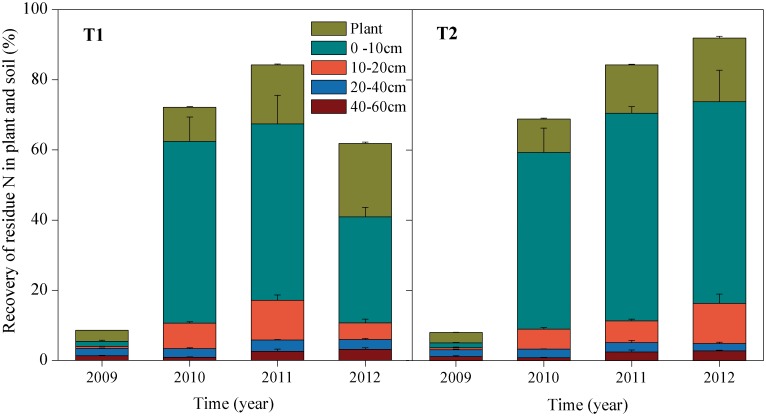
Cumulative recovery of residue N in soil and crop under different treatments during 2009 to 2012.Error bars indicate standard deviations, n = 3.